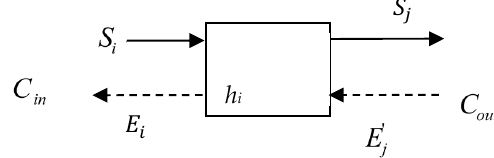
Figure 6. Outgoing Echo stream is chaffed.